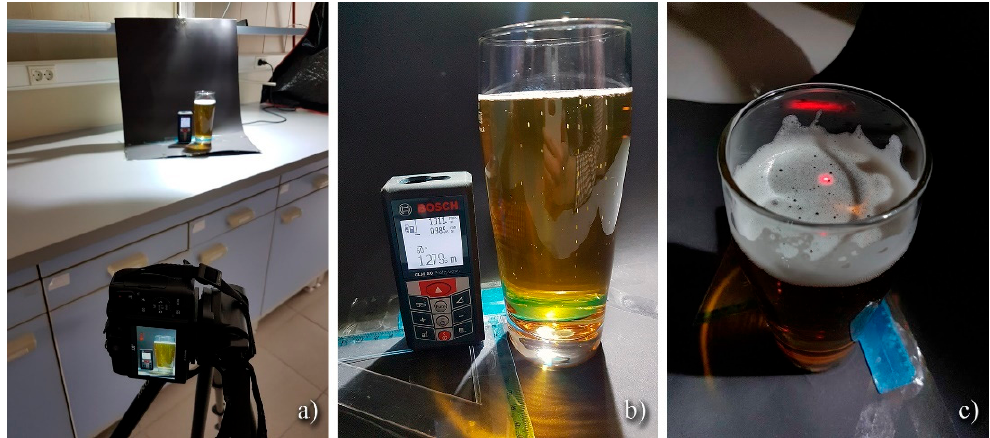
Figure 5. Photos of experimental setup: ( a ) general setup; ( b ) LDM and a sample; ( c ) laser dot on the beer foam.